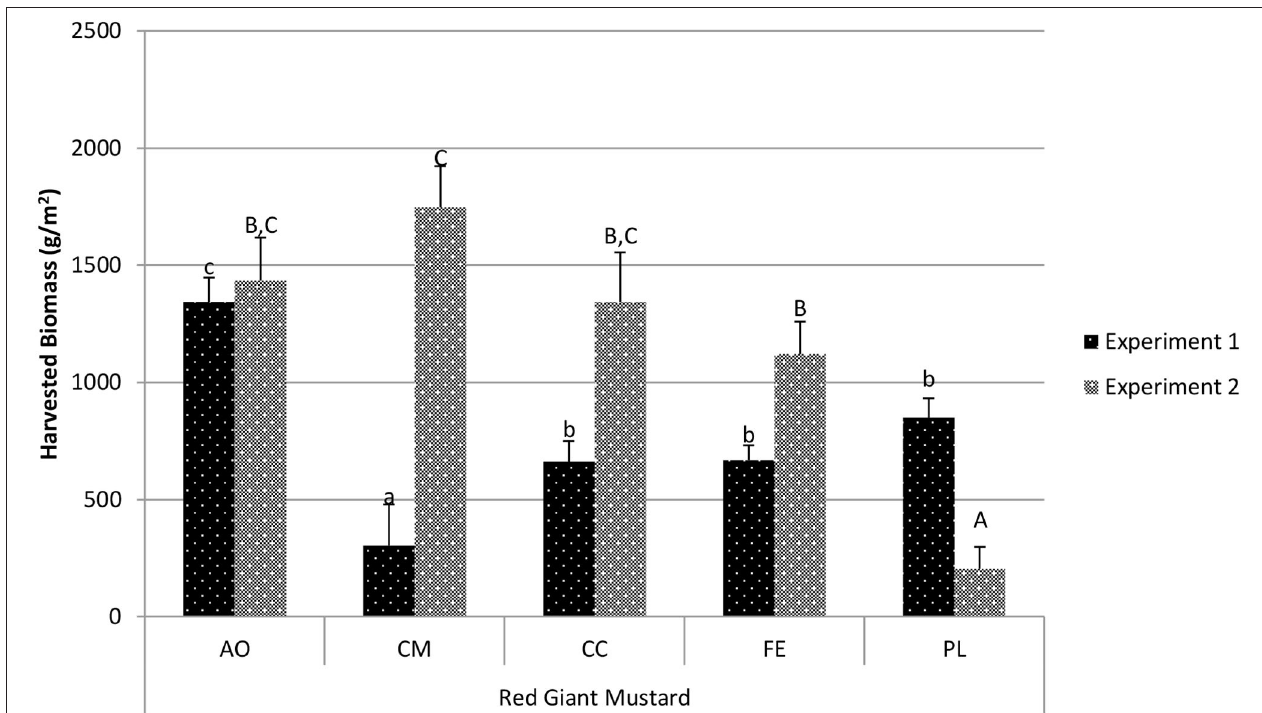
FIGURE 3 | Comparison of red giant mustard harvested biomass between treatments in experiment 1 and experiment 2. Data shown are mean ± standard deviation for two different replicate experiments. Significant differences among mean values are indicated with different letters above bars ( p < 0.05) with lower-case letters for experiment 1 and capital letters for experiment 2. Results analyzed using ANOVA Tukey HSD for significance